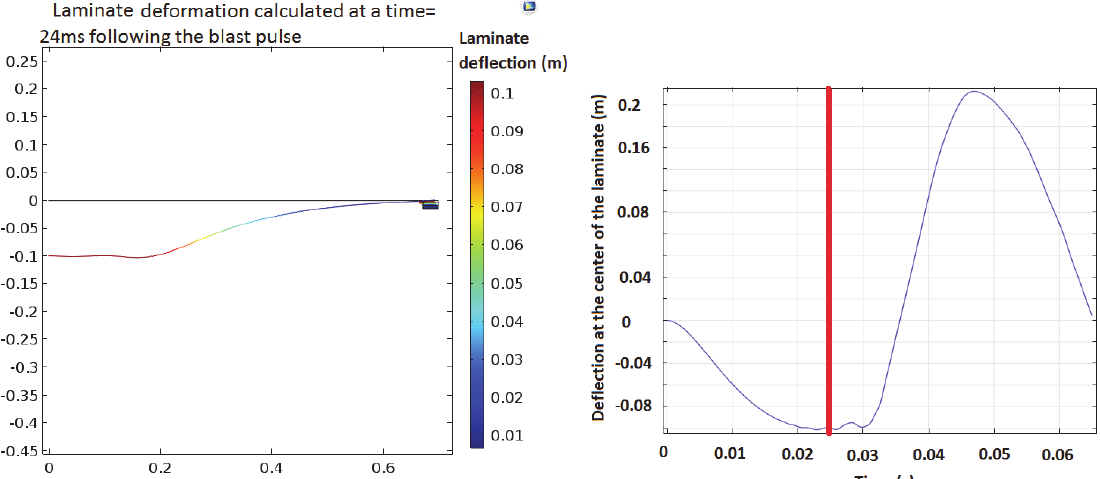
Fig. 5a: laminate deformation calculated at t=24ms (left Fig.); the red line on the right Fig. shows the deflection at laminate center corresponding to this time..